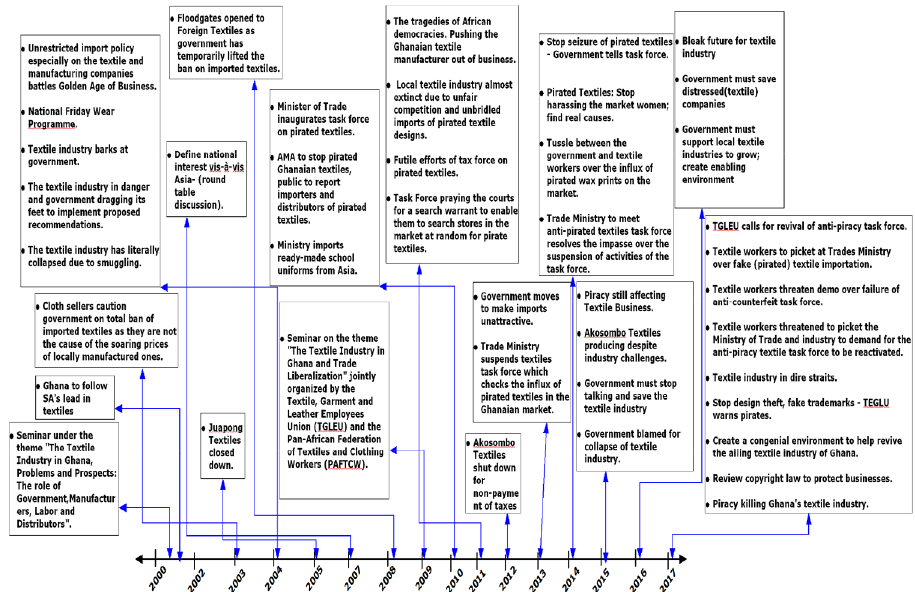
Figure 1. Archival timeline of the textile industry in Ghana representing a set of historical antecedents of the phenomenon understudy capturing key themes and concerns that have evolved in the textile sector (source: prepared by